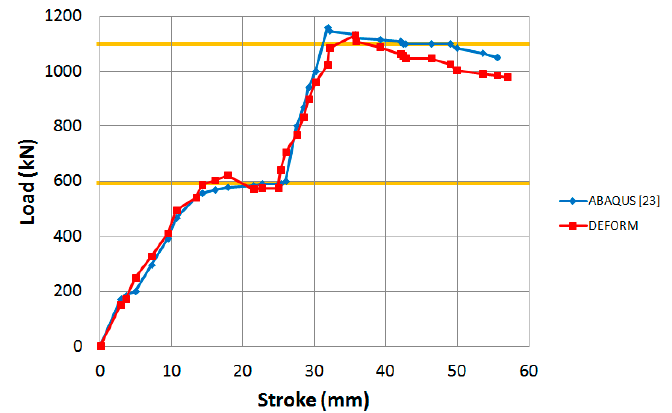
Figure 7. Extrusion force in a double-pass extrusion for Cf53 steel obtained by the finite element software ABAQUS [23] and DEFORM-F2. Yellow horizontal lines show approximate values of the maximum forces required to extrude the workpiece in each pass.